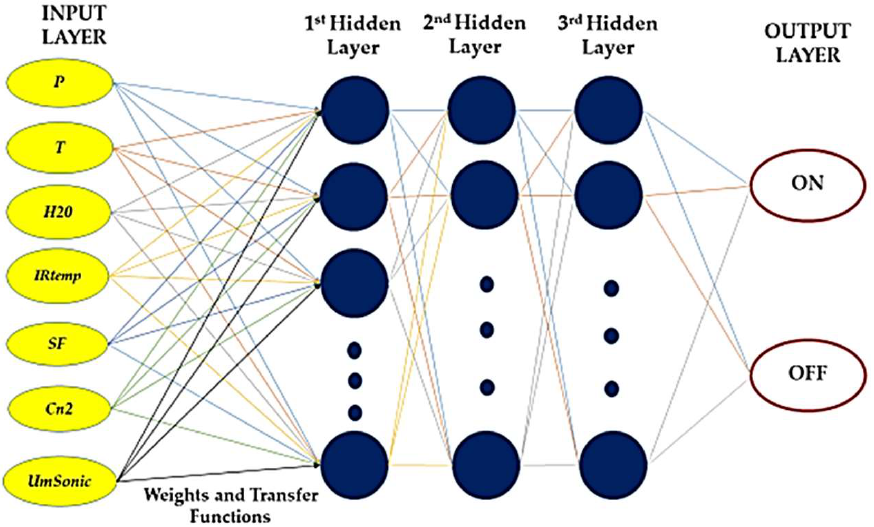
Figure 11. The Deep Neural Network approach to classify the FSO link laser mode status.